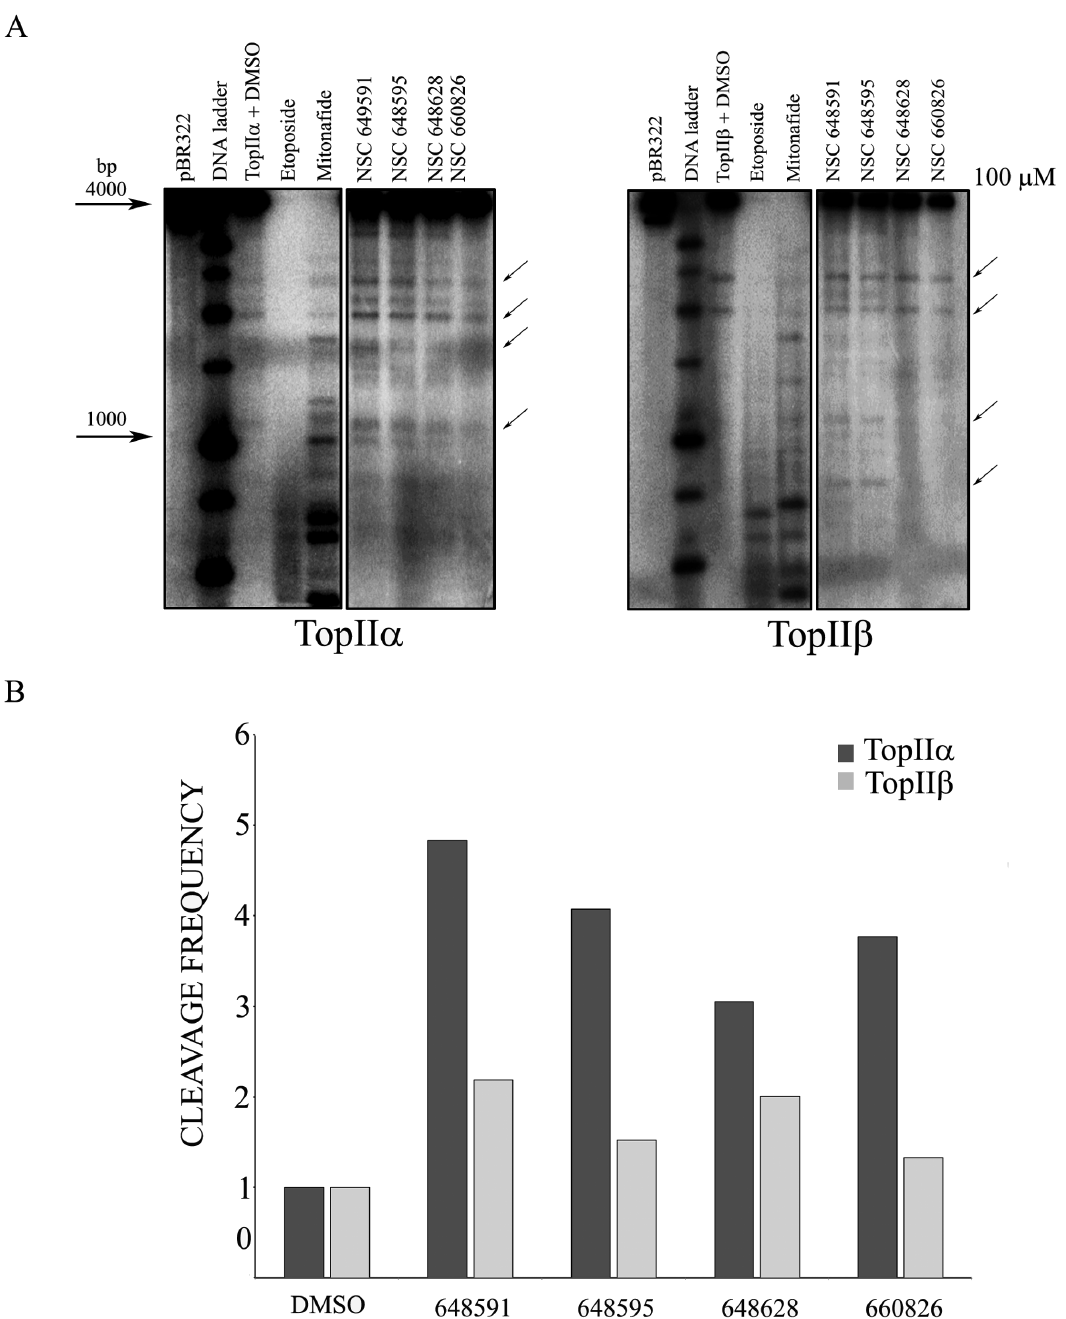
Fig. 5. Top2 a and b cleavage assays with selected compounds. A) The 4 active inhibitors of Top2 a identified in Fig. 4B) were additionally tested at 100 m M concentration on both isoforms. The arrows show bands used for densitometric analysis. B) Preferential selectivity of selected compounds for the Top2 a isoform. Semiquantitative analysis of cleavage product band densities was performed with Image Quant software (Molecular Dynamics). Data are reported from representative experiments as frequency of cleavage.